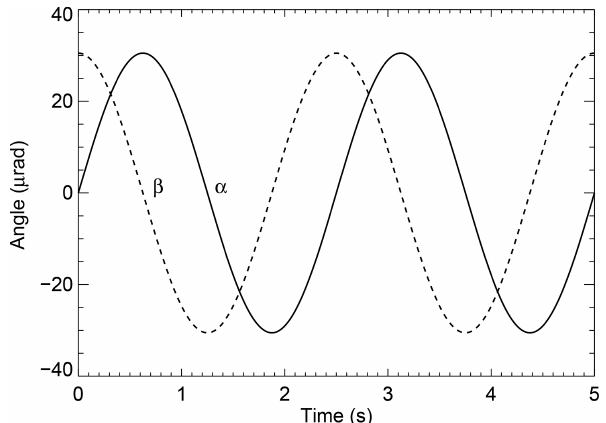
Figure 6. Position of the laser beam and telescope boresight during a conscan (adapted from Gawronski and Craparo,